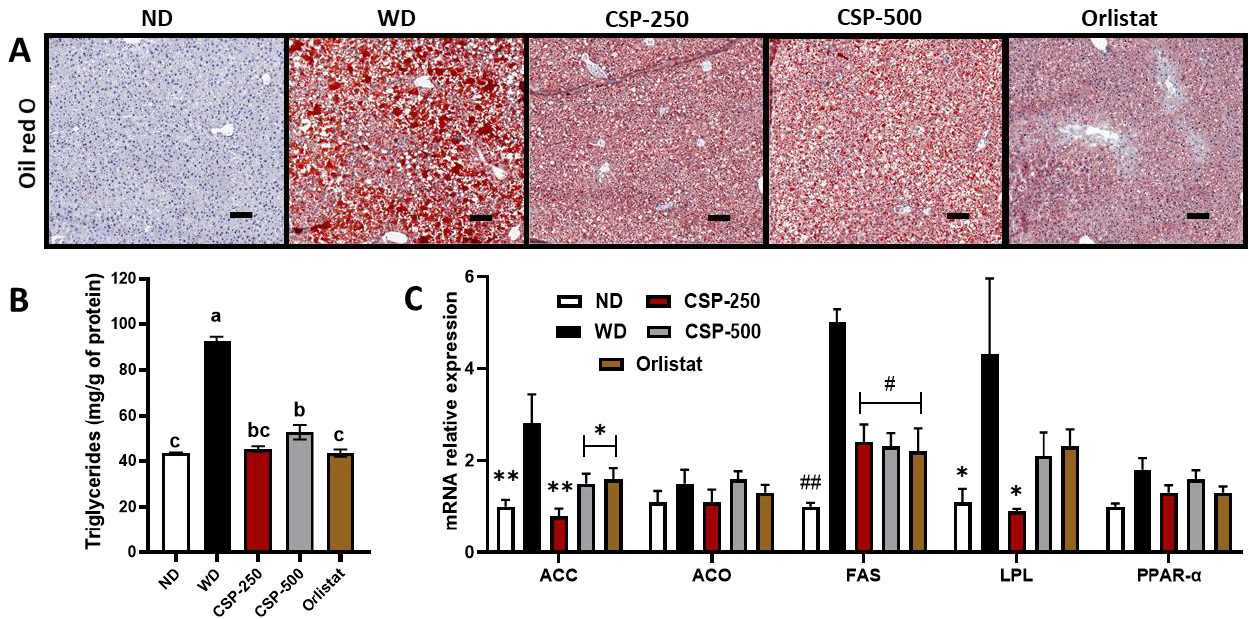
Figure 4. ( A ) Prevention of liver steatosis by daily administration of canary seed peptides (CSP) for an eight-week diet induce intervention in C57BL/6J mice. Magnified histological liver sections (200 × ) stained with hematoxylin-eosin Oil red O (Scale bar, 100 µ m for all). ( B ) Triglycerides levels and, ( C ) lipid metabolism related gene expression on hepatic tissue. ND, normal diet; WD, Western diet; CSP-250, mice supplemented with 250 mg/kg of body weight of CSP; CSP-500, mice supplemented with 500 mg/kg of body weight of CSP; Orlistat, mice supplemented with 40 mg/kg of body weight of orlistat. Bars and lines represent mean values ± SEM ( n = 8 per treatment). Different letters (a – c) indicate statistical differences ( p < 0.05) between treatments. * p < 0.05, ** p < 0.05, # p < 0.005, and ## p < 0.0001 vs. WD group.